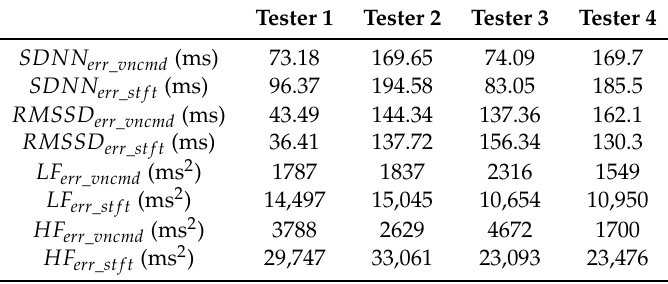
Table 3. Heart rate variability analysis on on moving testers in Track 1.